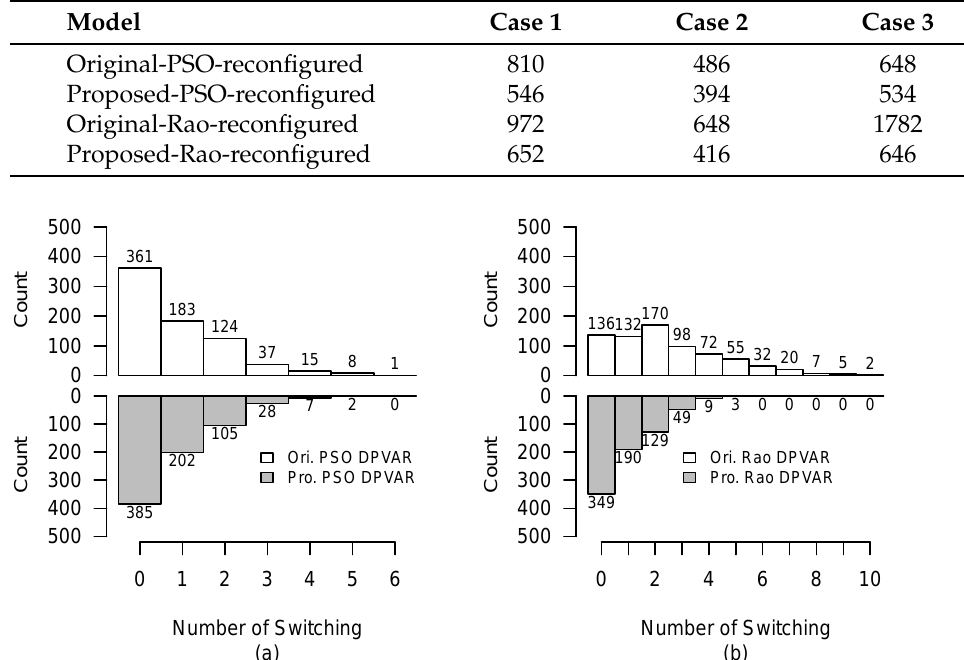
Table 4. Summary total number of switching times of PV array without time lagging.